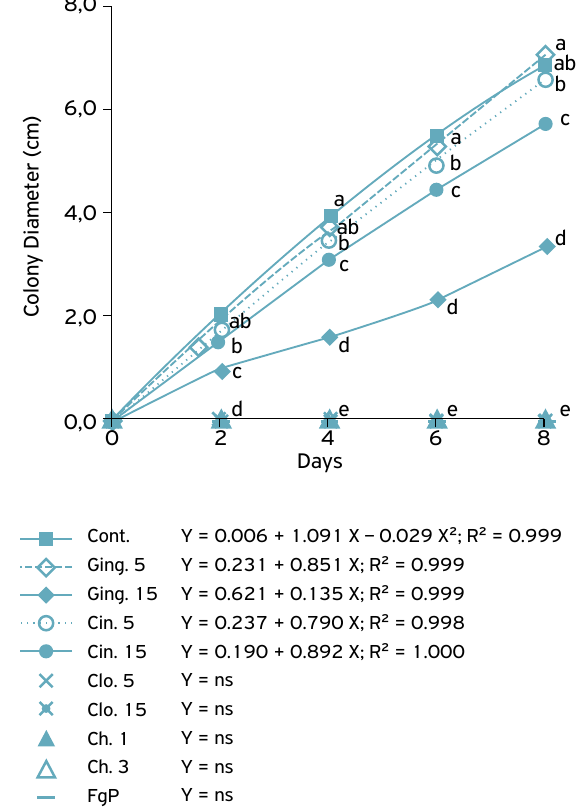
Figure 1. Mycelial growth (cm) of Colletotrichum gloeosporioides under the effect of treatments: control (Cont.); 5% ginger (Ging. 5); 15% ginger (Ging. 15); 5% cinnamon (Cin. 5);